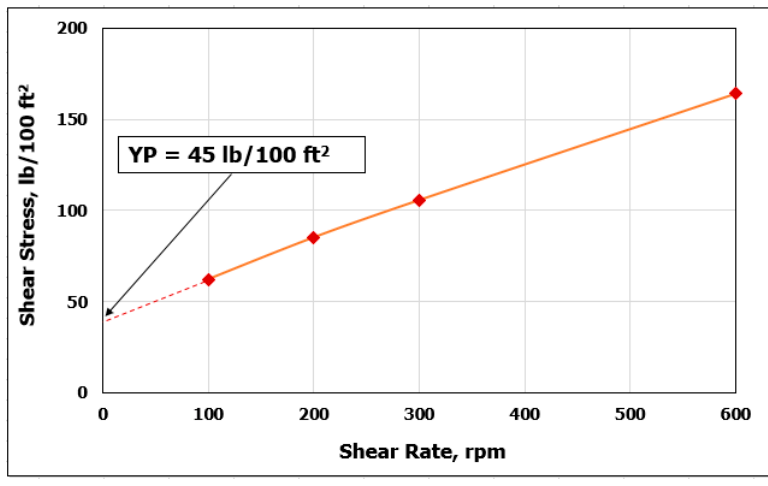
Figure 1. Shear rate vs. shear stress for HBM at 120 °F and atmospheric pressure.